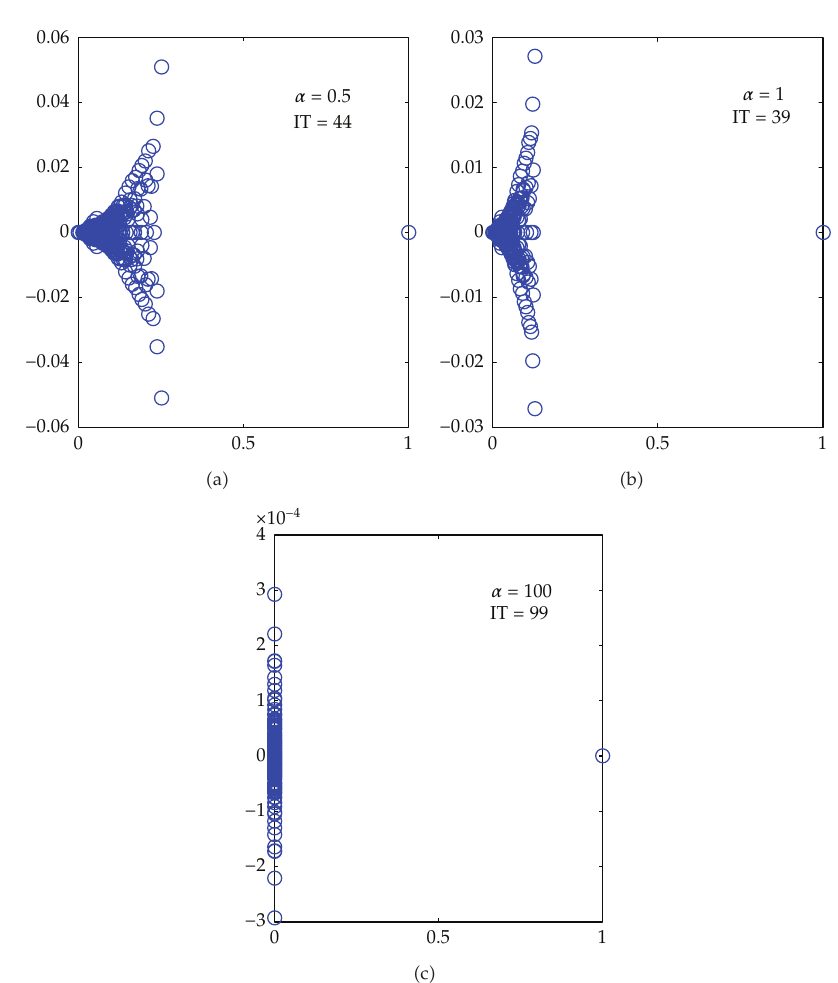
Figure 1: Spectrum of preconditioned steady Oseen matrix, 32 × 32 grid with υ (cid:6) 0 .